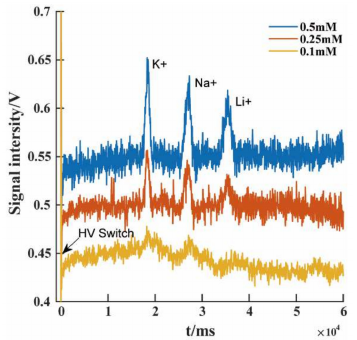
Figure A3. An electropherogram of three concentrations of device with traditional C4D. Operational conditions were the same as in Figure